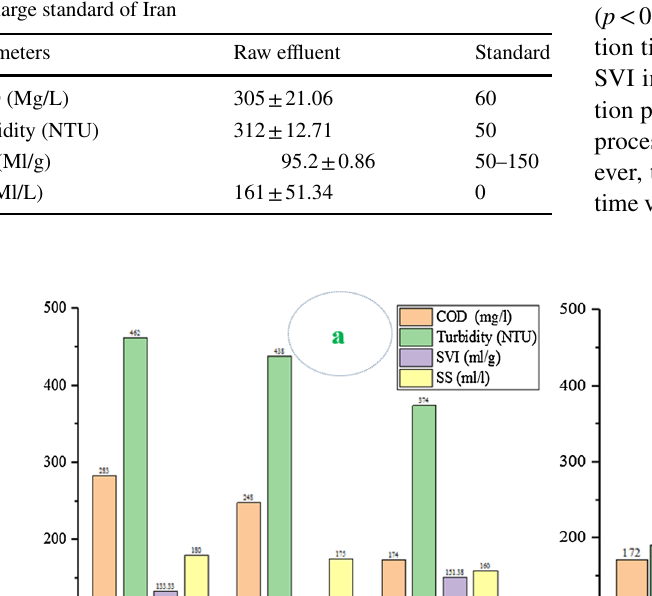
Table 2 Specifications of the studied raw effluent and environmental